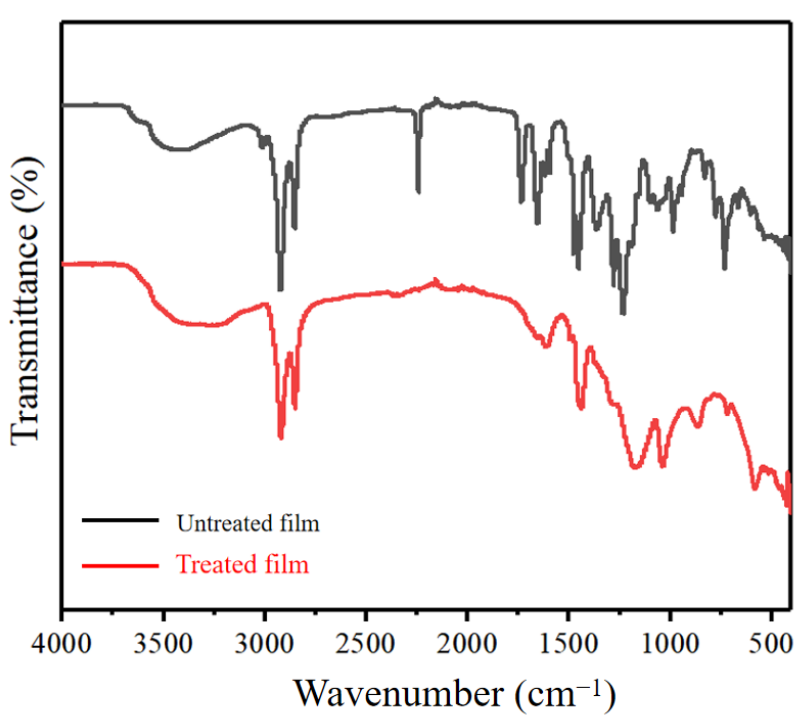
Figure 7. FT-IR spectra of the 7:5 nanoscale urushiol/PAN film immersed in 100% sulfuric acid solutions.